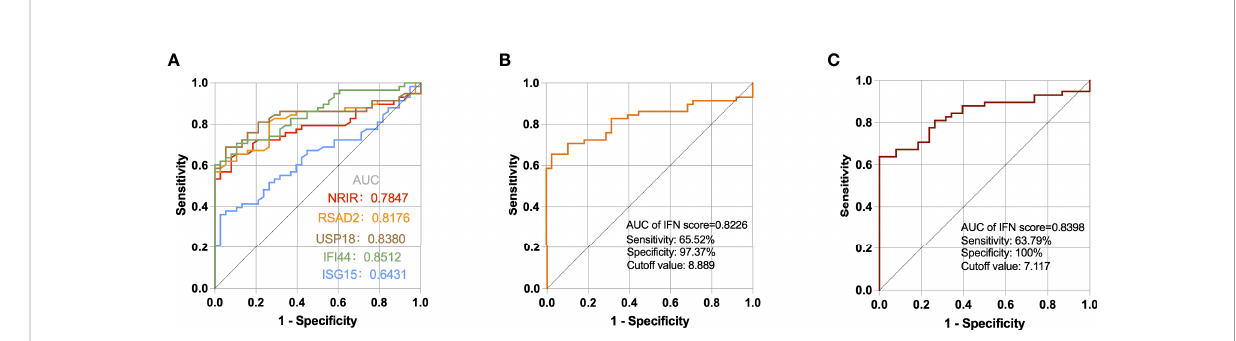
FIGURE 6 ROC curves for the 5 ISGs (A) , IFN score calculated by 5 ISGs (B) , and IFN score calculated by IFI44, USP18, and RSAD2 (C) in SLE patients compared with healthy